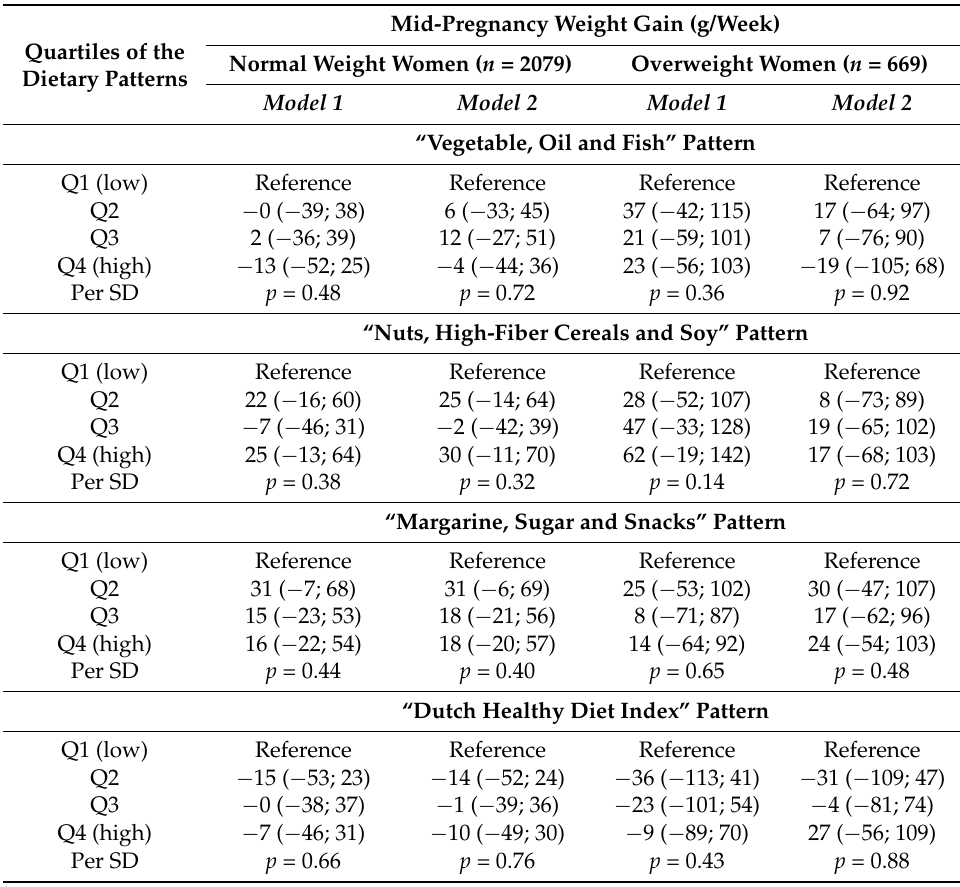
Table 4. Association of dietary patterns with gestational weight gain in mid-pregnancy ( n = 2748) 1 .